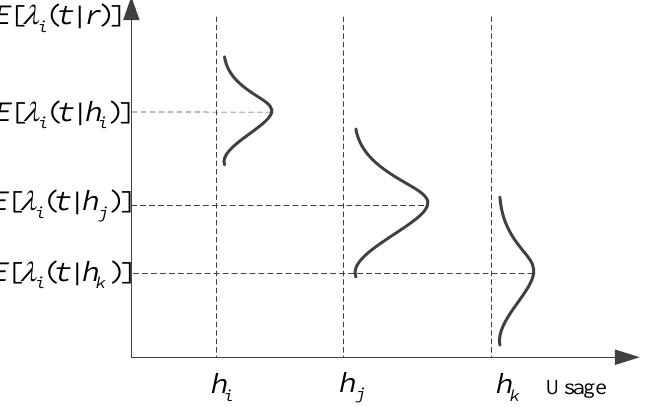
Figure 1. Failure rate function of components under different utilization rates. Step 4: All the failure rate curves fitted under the specific utilization rate are visualized in three-dimensional space; then, a three-dimensional surface can be fitted through these curves, i.e., the two-dimensional failure rate function expression ( | ) and r .